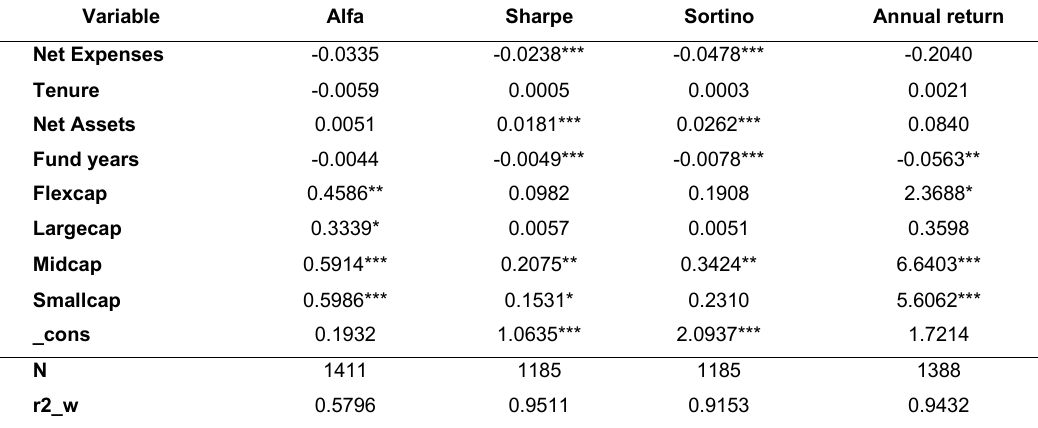
Table 2. Regression of expenses and performance, with random